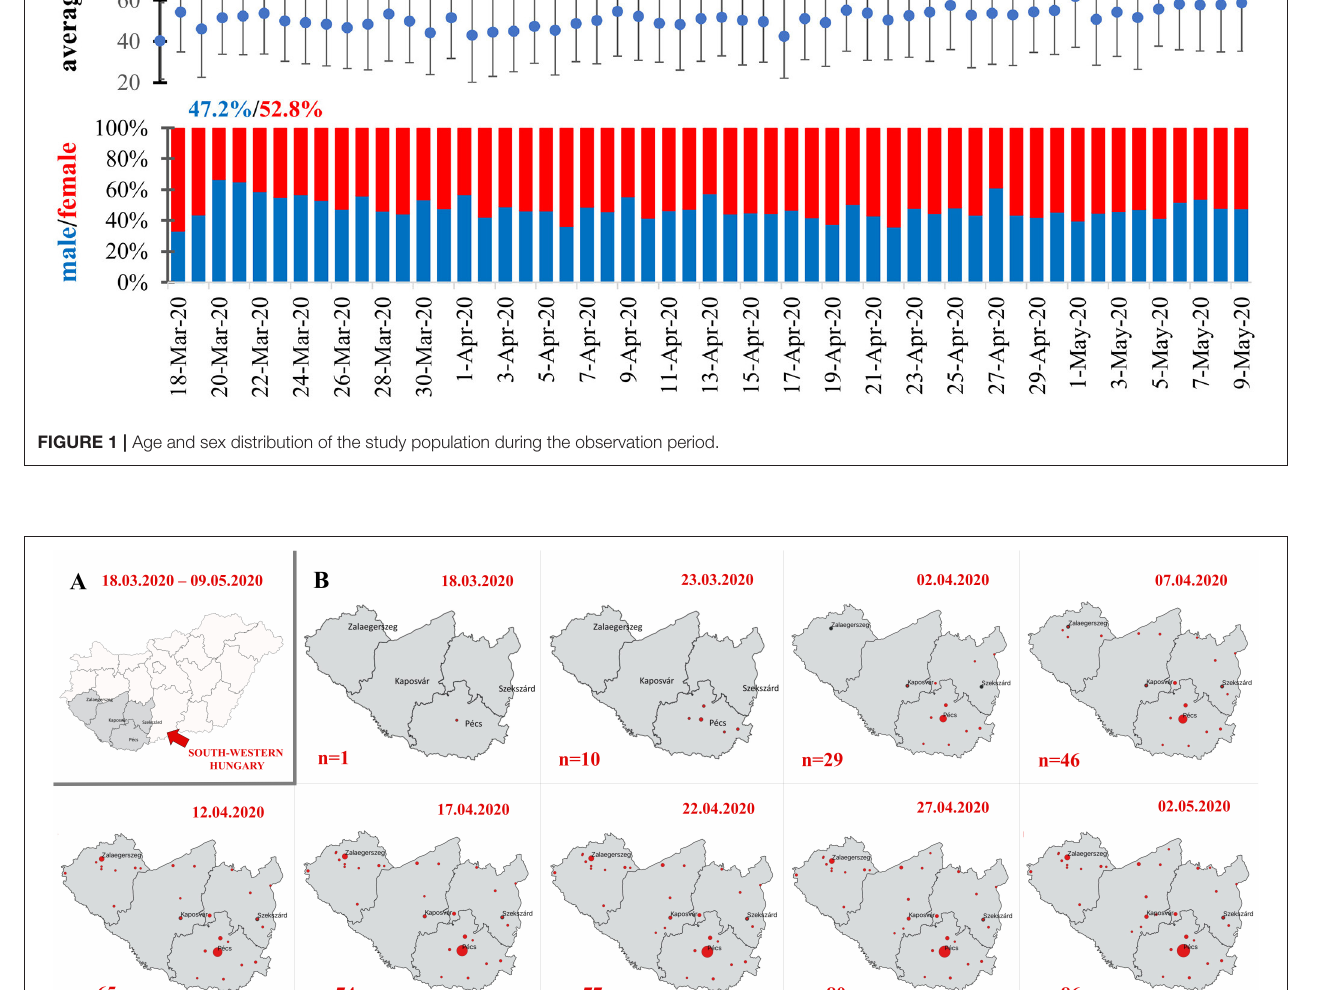
18,957 vs. 9,437 ± 23,326; W = 33, p = 0.916) among health care providers. Absolute quantification of the SARS-CoV-2 genetic segments also allowed us to characterize the individual disease progression with copy number changes. E-gene